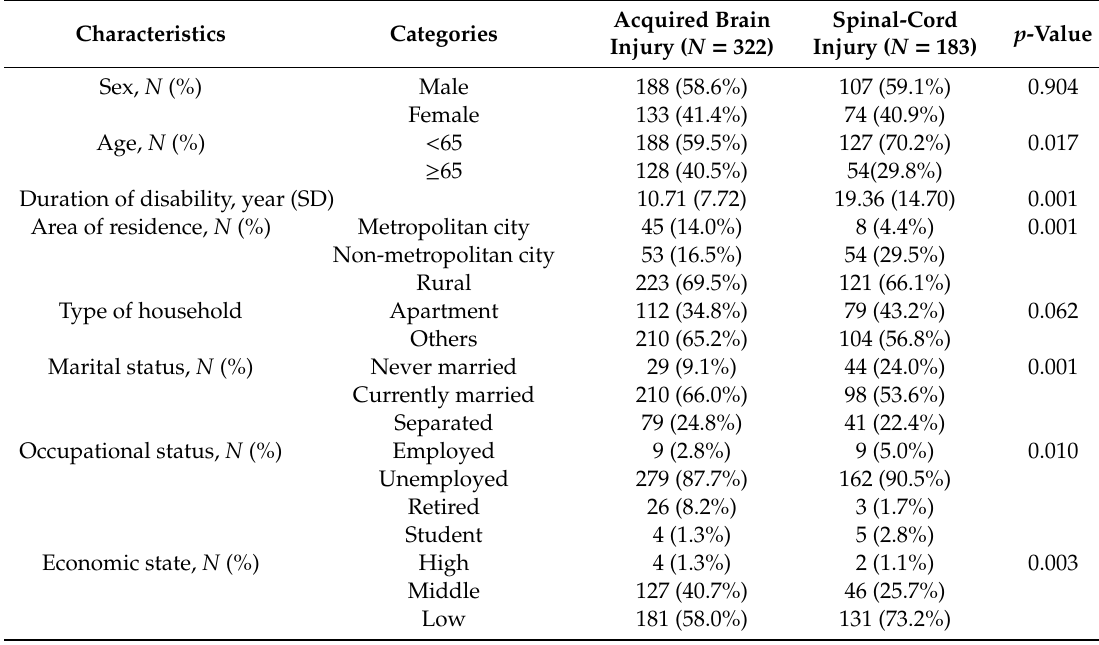
Table 1. General characteristics of participants ( N =